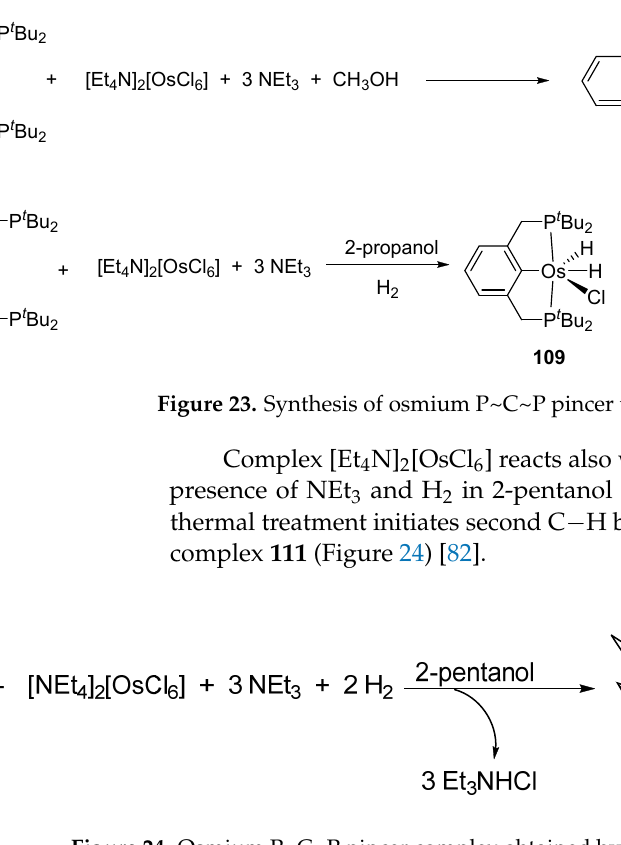
20 of 51 Figure 22. Synthesis tris -cyclometalated complex from the osmium dimer precursor. 3.5. Other Precursors Complexes [cation] 2 [OsX 6 ] and [OsX 3 (tterpy)] (tterpy = 4 ′ -(4-tolyl)-2,2 ′ :6 ′ ,2 ″ -terpyri- dine) were also used as osmacycle precursors. Complex [Et